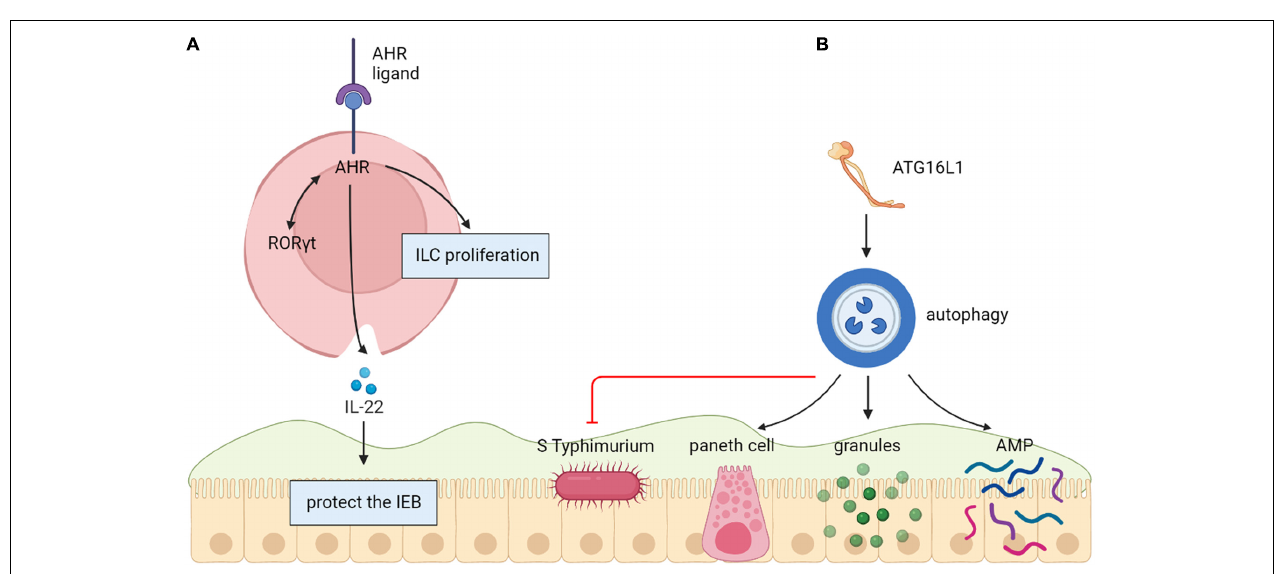
FIGURE 3 | (A) Aryl-hydrocarbon receptor (AHR) protect the intestinal epithelial barrier. Directly binding to the Il22 promoter, AHR induces Il22 expression in ILC3 by acting together with ROR γ t. (B) Autophagy (ATG16L1) protects the intestinal epithelial barrier. The decrease of Atg16l1 led to fewer Paneth cells and abnormal granule morphology, resulting in decreased expression of AMP, which growing inflammation and comprehensive translocation of bacteria.